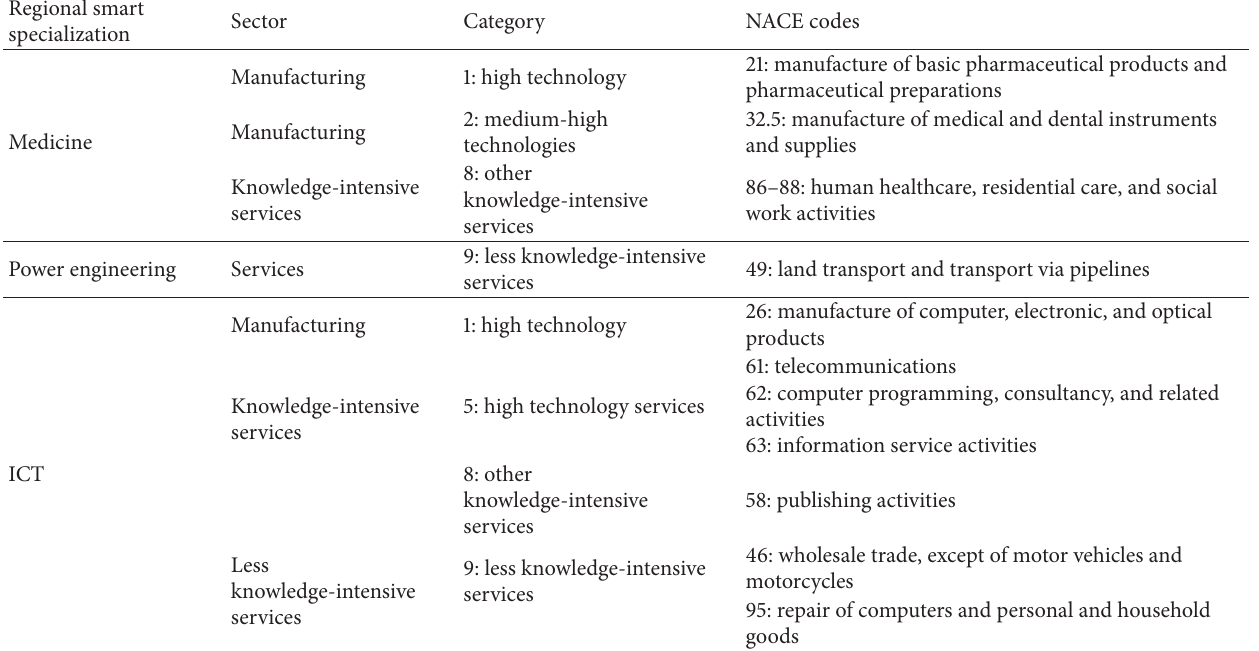
Table 8: Interrelations between economy activity based on classification of manufacturing and services by R&D intensity for regional smart specializations of medicine, power engineering, and ICT (the sixth